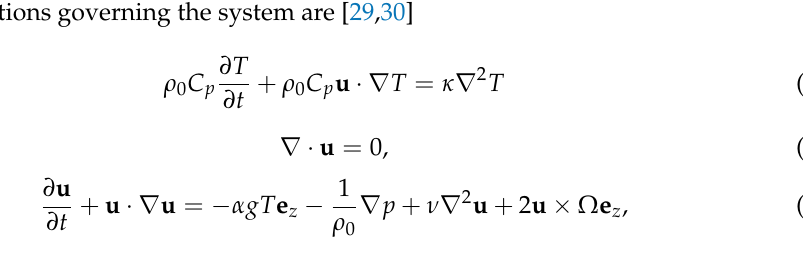
Figure 1. ( a ) Numerical setup; ( b ) Distribution of monitored points in the slice φ = 0 of the